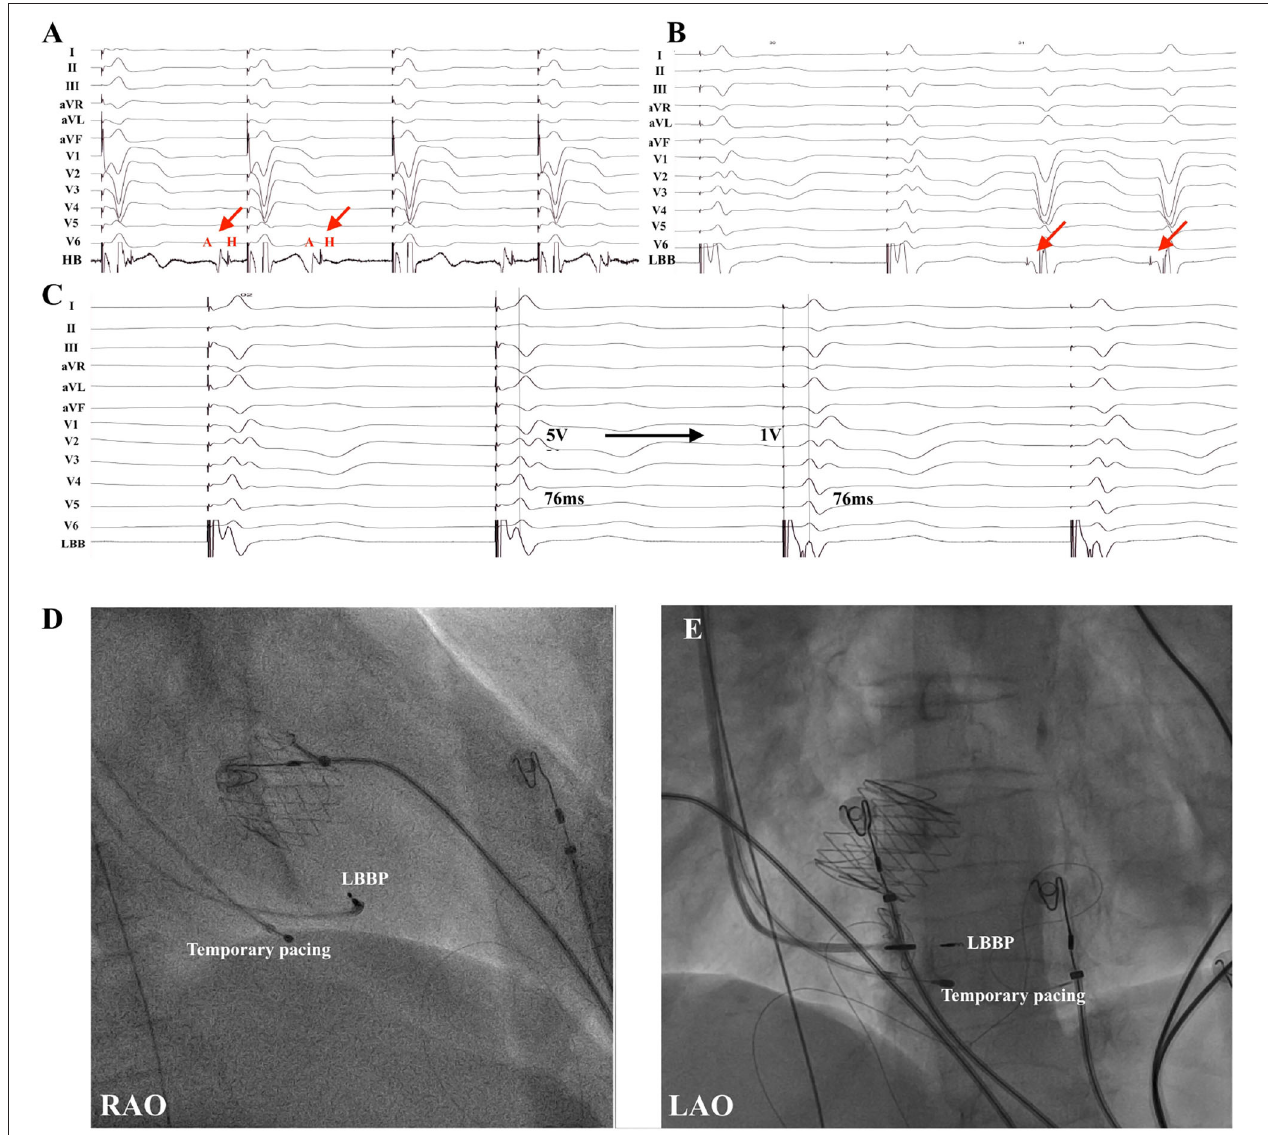
FIGURE 3 | LBBP in a patient with TAVR (patient no. 19). (A) Example of a 71-year-old male who underwent TAVR and developed infranodal block. (B) Intrinsic rhythm with LBBB occurred after cessation of temporary right ventricular pacing and LBB potential (red arrow) was noted. (C) Pacing at 5V resulted in correction of LBBB with nonselective LBBP with local myocardial fusion and stim-LVAT of 76ms. Selective LBBP with discrete local ventricular myocardial electrogram was shown during pacing at 1V with the same stim-LVAT of 76ms. Note the subtle change in QRS morphology in lead V1 and intracardiac electrograms. (D,E) Fluoroscopic views